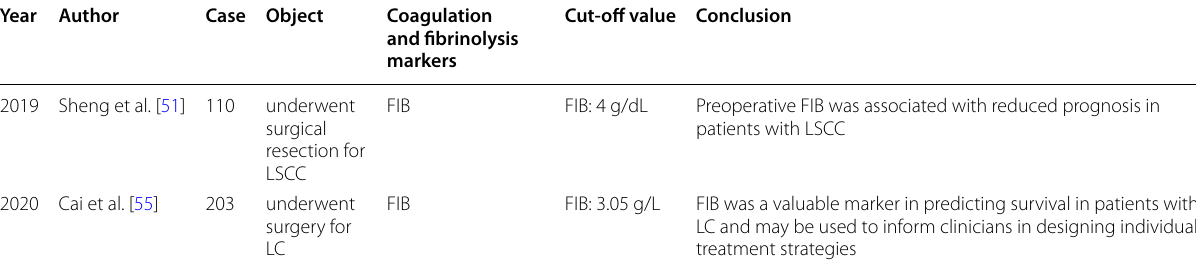
Table 2 Clinical studies in which predictive and prognostic role of FIB was evaluated in patients with LSCC Year